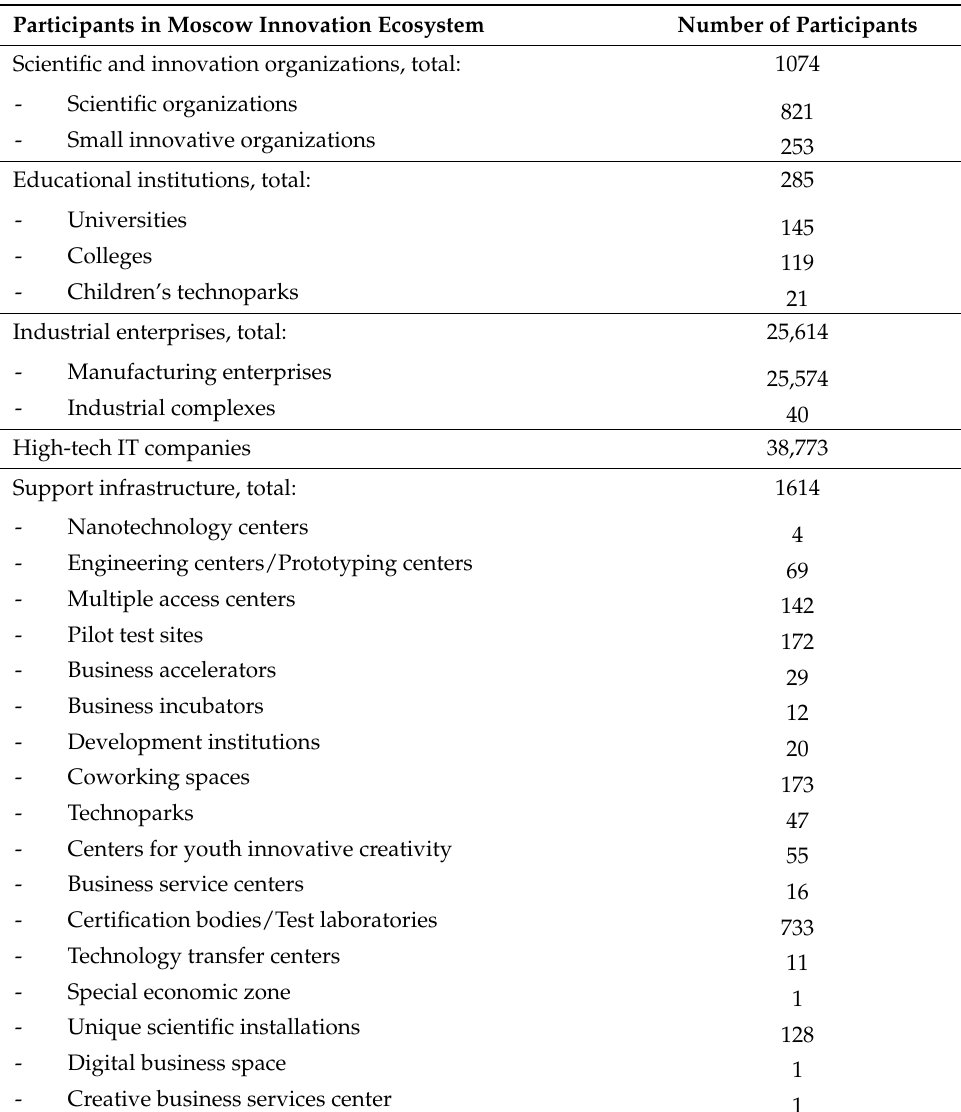
Table 5. The composition of the innovation system